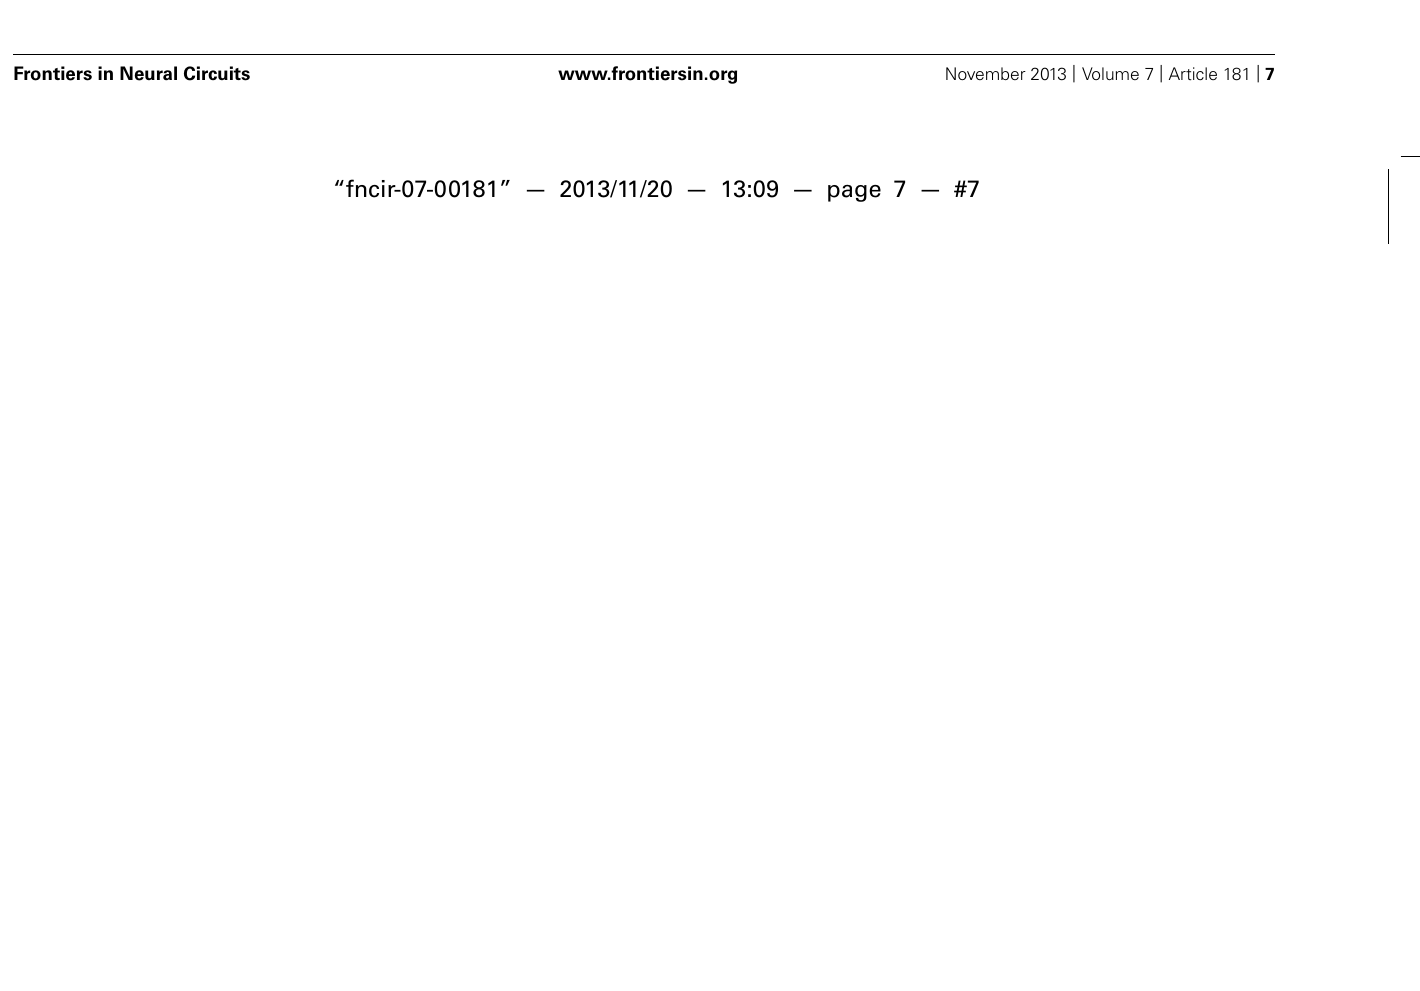
center of the corpus callosum.The DiI stain is compared against a coronal section ( ∼ 4.2 mm from Bregma) taken from a non-implanted rat of the same strain and age stained